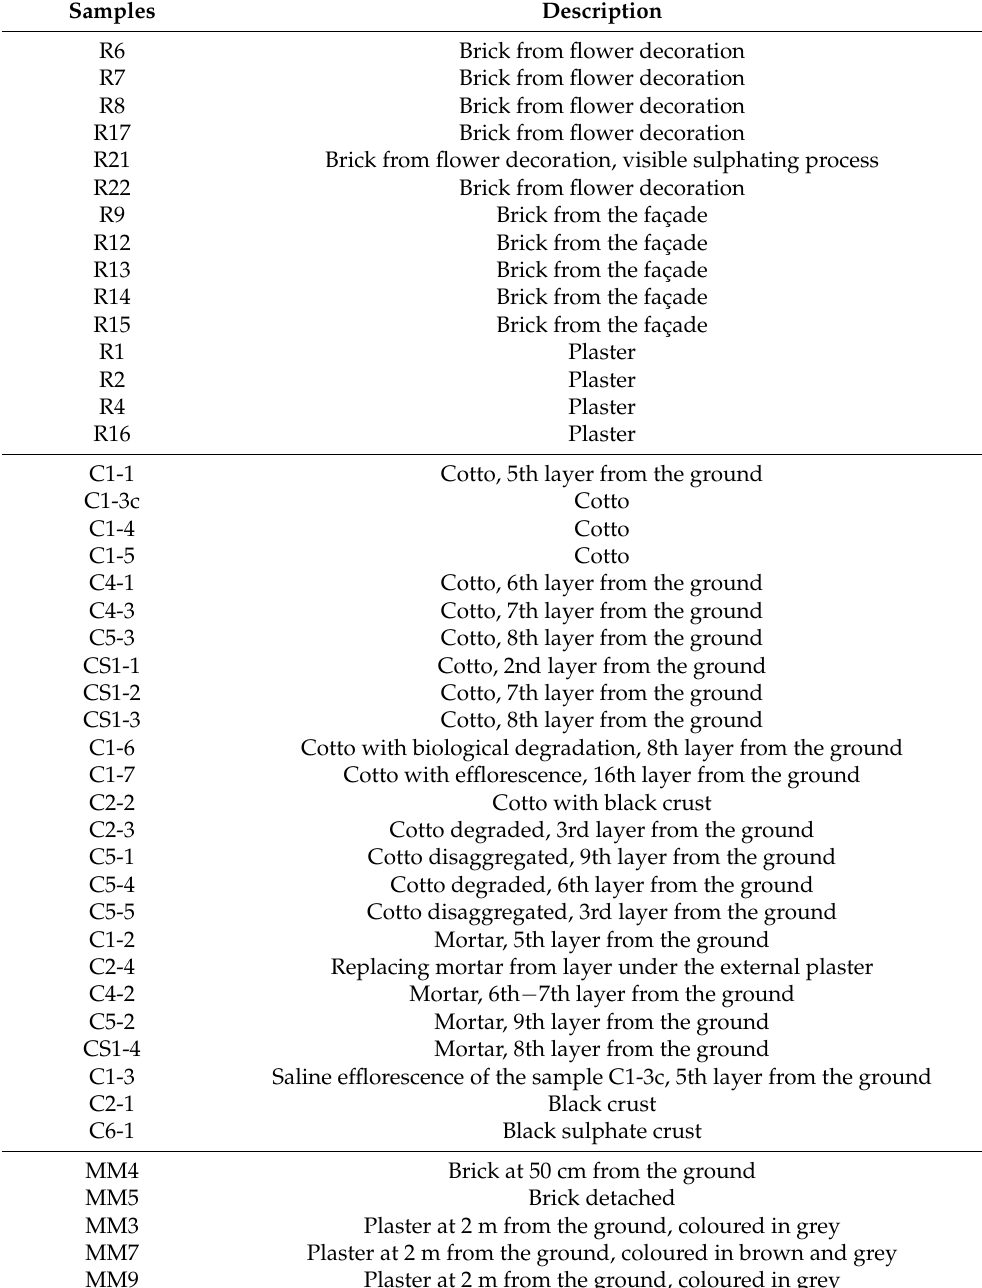
Table 1. List of samples collected and analyzed specifying the type of sample: R represents the samples from Palazzo Roverella, C: samples from Santa Maria delle Grazie and MM: samples